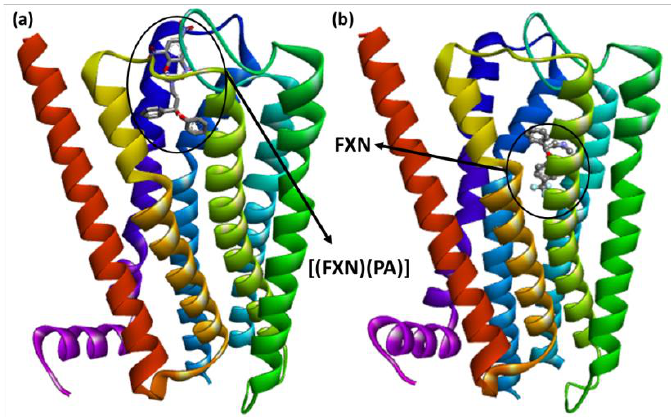
Table 2. Interaction data of [(FXN)(PA)] – serotonin and (FXN) – serotonin (PDB ID: 6A94).